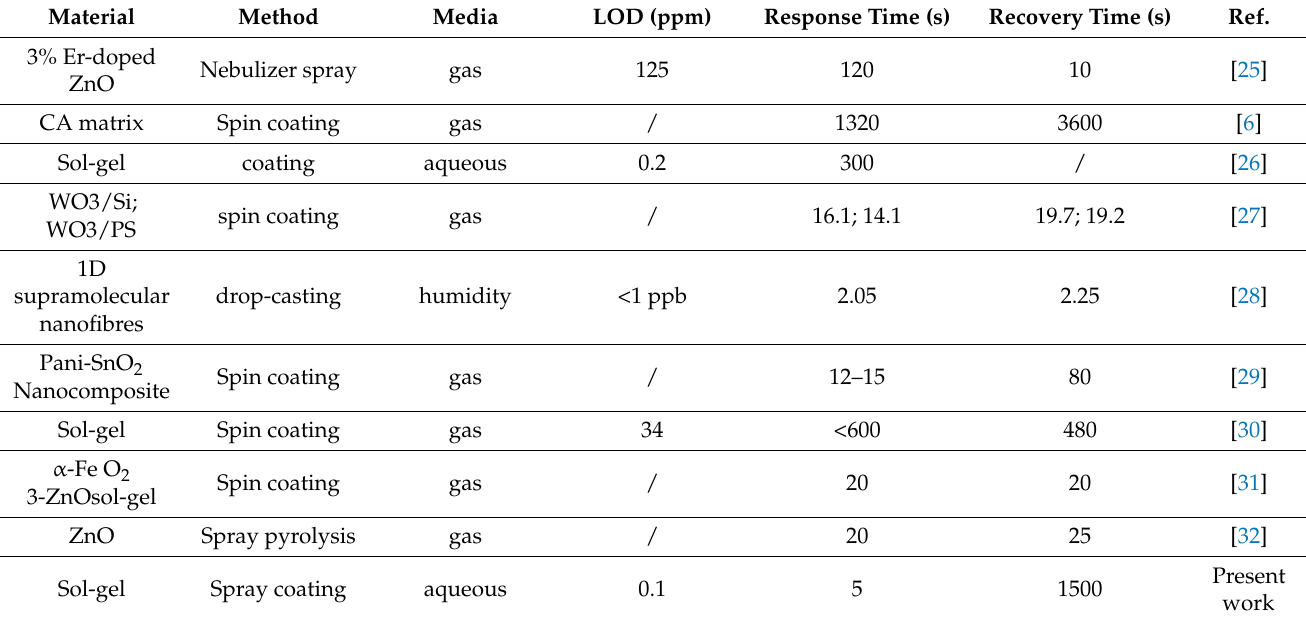
Table 1. Comparison of sensing characteristics of various sensors for NH 3 detection in different media, prepared with coating